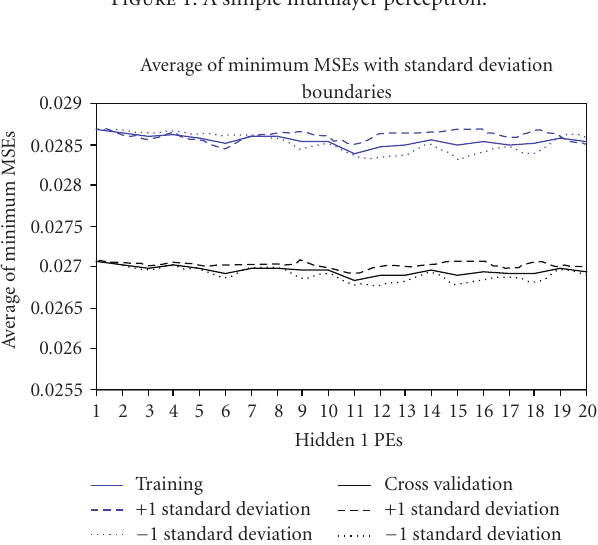
Figure 2: Variation of average of minimum MSE for 5 runs versus number of PEs in the first hidden layer.